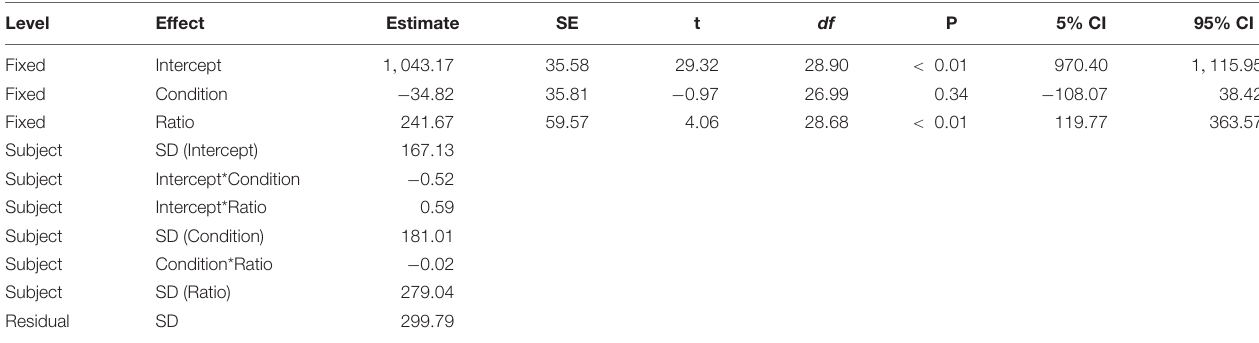
TABLE 3 | Linear Mixed Model for the effect of condition (Loss = 0, Reward = 1) and ratio between immediate and delayed options (0.2, 0.4, 0.6, 0.8) on reaction times during the decision phase ( N = 30).